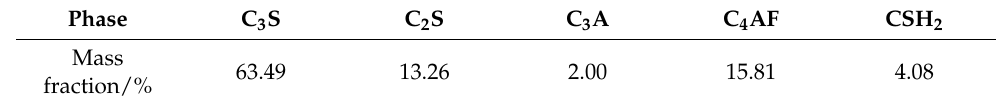
Table 1. The mineral components of GOC.